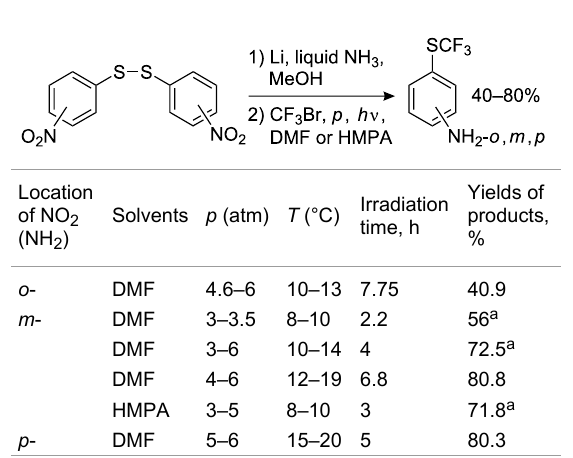
Table 8: Preparation of aminophenyl trifluoromethyl sulfides with CF 3 Br (3–7 atm) and UV irradiation with preliminary reduction of dini- trodiphenyl disulfides [179].